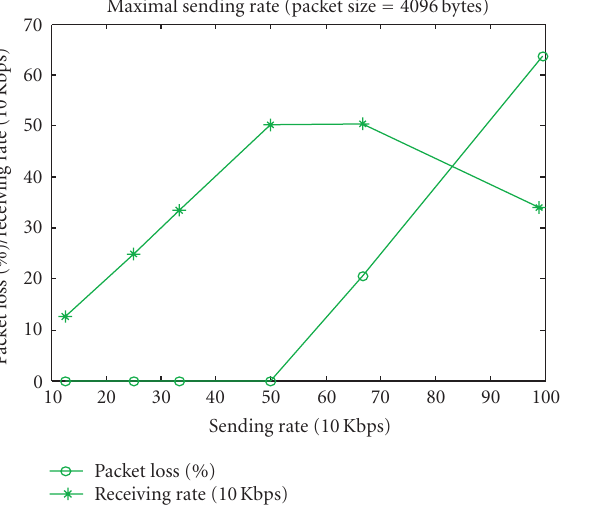
Figure 8: E ff ect of sending rate on packet loss.